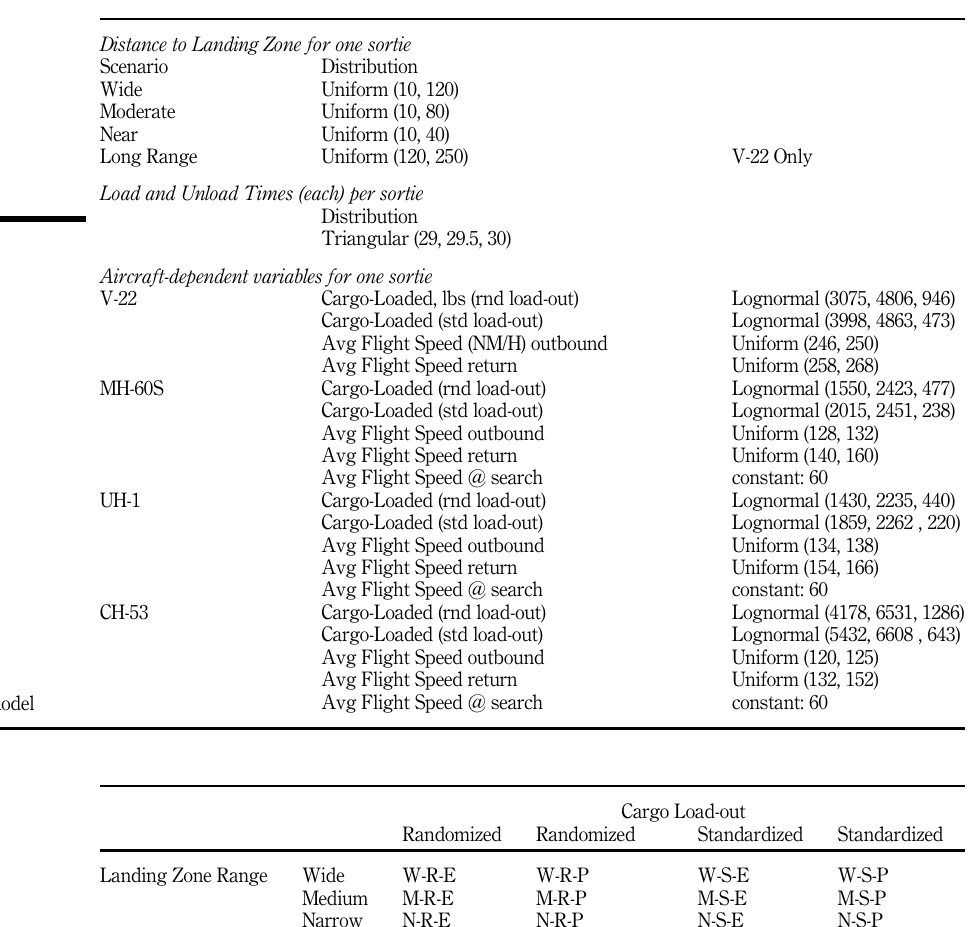
Table 2. Parameter